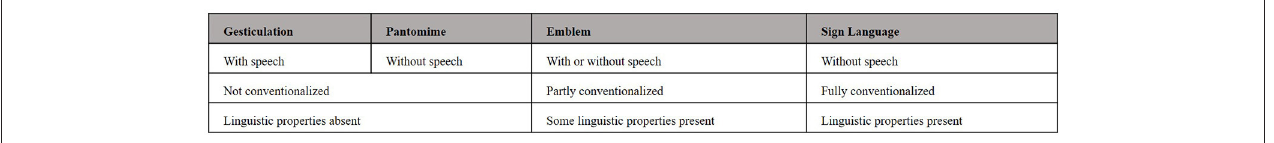
FIGURE 1 | Kendon’s continua: Relationship between gestures and speech, convention, and linguistic properties, as proposed by McNeill